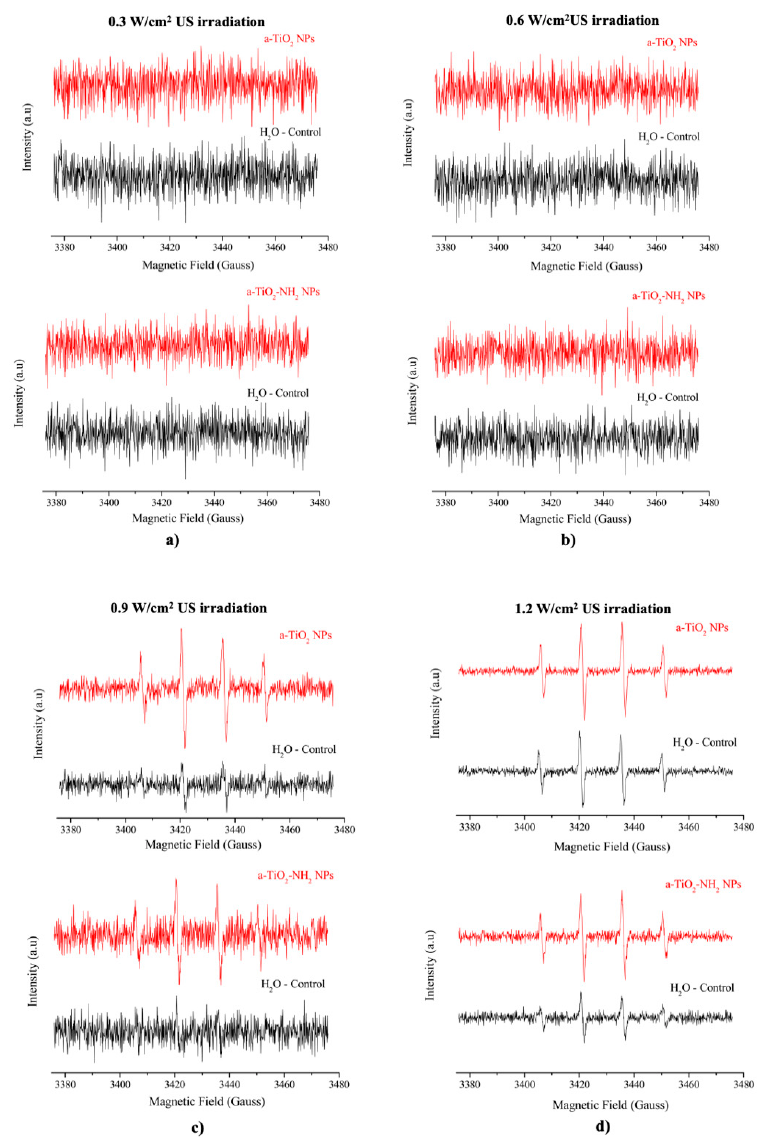
Figure 5. EPR spectra of amine-functionalized (graphs on top) and pristine (graphs on the bottom) a-TiO 2 based NPs (200 μ g/mL) in water using DMPO (10 mM) as spin trap, irradiated with different US powers: ( a ) irradiation of 0.3 W/cm 2 of US, ( b ) irradiation of 0.6 W/cm 2 of US; ( c ) irradiation of 0.9 W/cm 2 of US; ( d ) irradiation of 1.2 W/cm 2 of US. Black spectra: control sample—water without NPs; red spectra: water with 200 μ g/mL of a-TiO 2 based NPs.